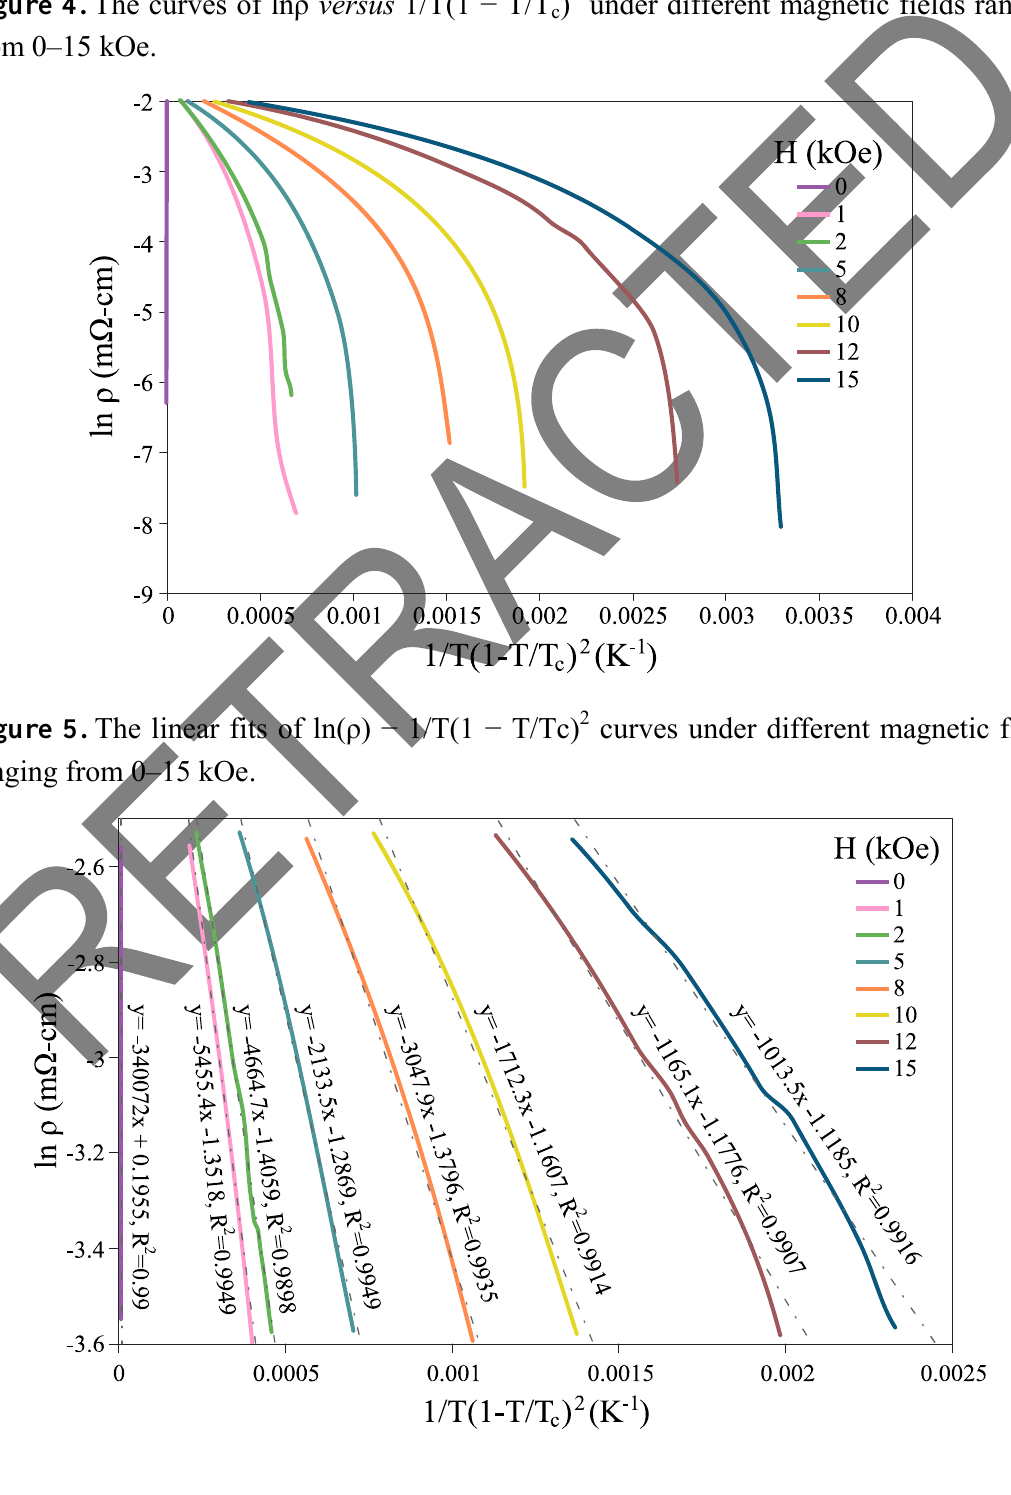
) 2 under different magnetic fields ranging c